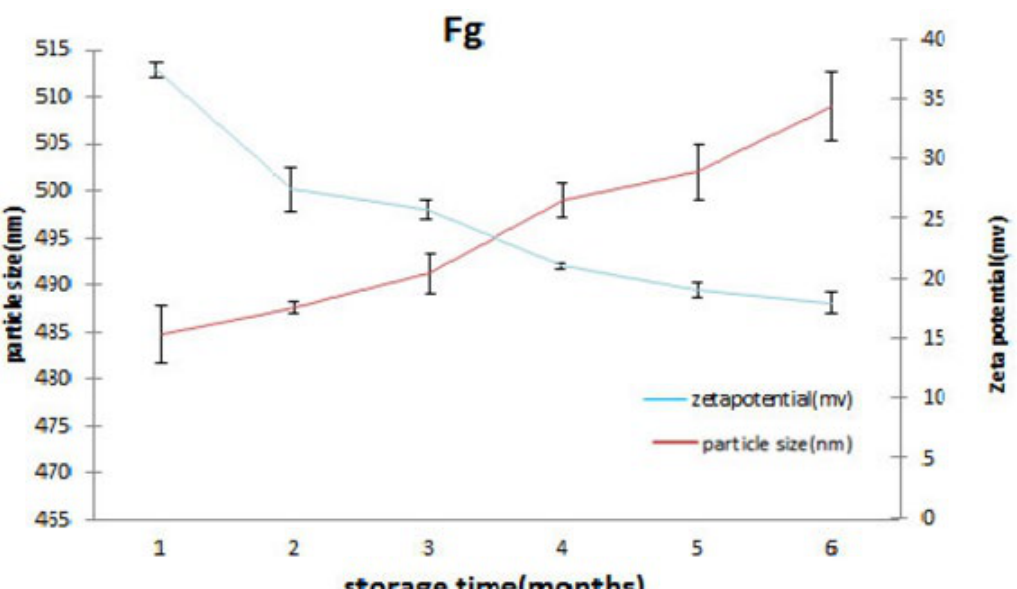
FIGURE 9 - Particle size and zetapotential of reconstituted Fg (chitosan/TPP-Alginate nanoparticles) upon storage for 6 months at room